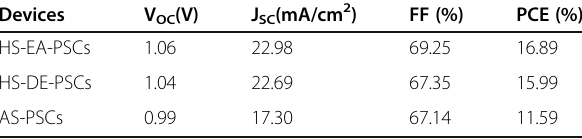
Table 1 Photovoltaic parameters of PSCs based on different perovskite